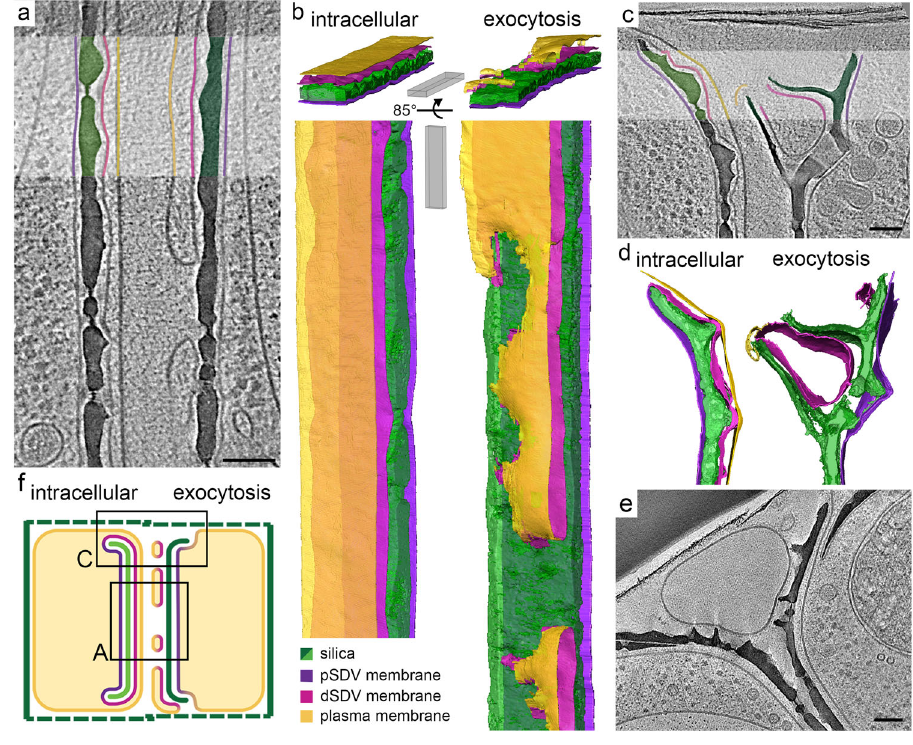
Fig. 4 | In-cellcryo-ET shows the native-state anatomy ofvalve exocytosis in T. pseudonana .a , c , e Slicesthroughreconstructed3Dvolumes;somefeaturesinthe highlighted rectangles are arti fi cially colored according to the color code in b (pSDV membrane - proximal SDV membrane, dSDV membrane - distal SDV